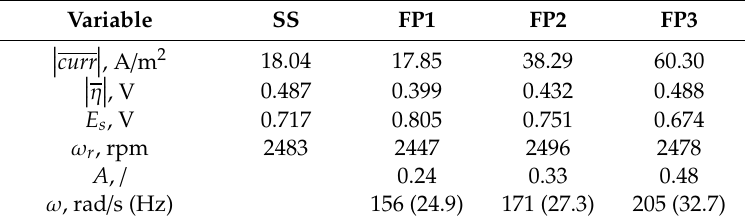
Table 6. Optimal current density (BI), overpotential (CI), and corresponding operational values for Example 2: ECR and Cases: SS, FP1, FP2, and FP3.